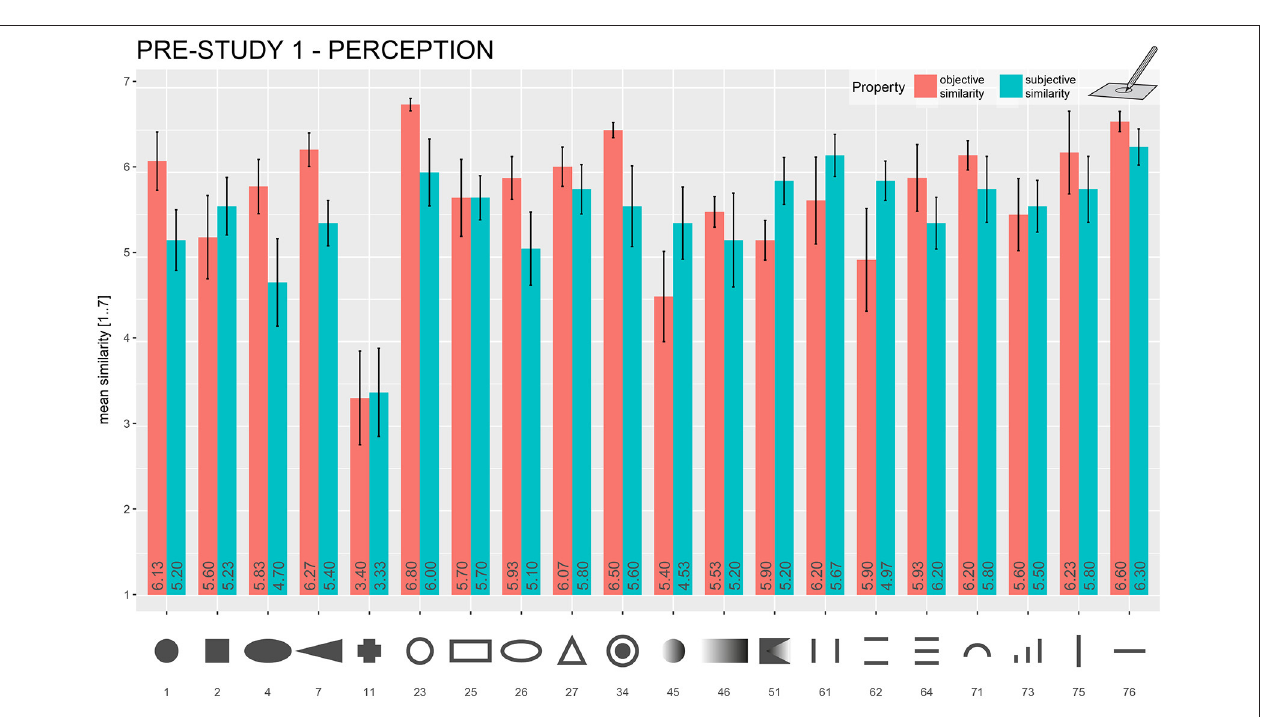
haptic forms were presented in a randomized order for each block. The participants were asked to freely explore both